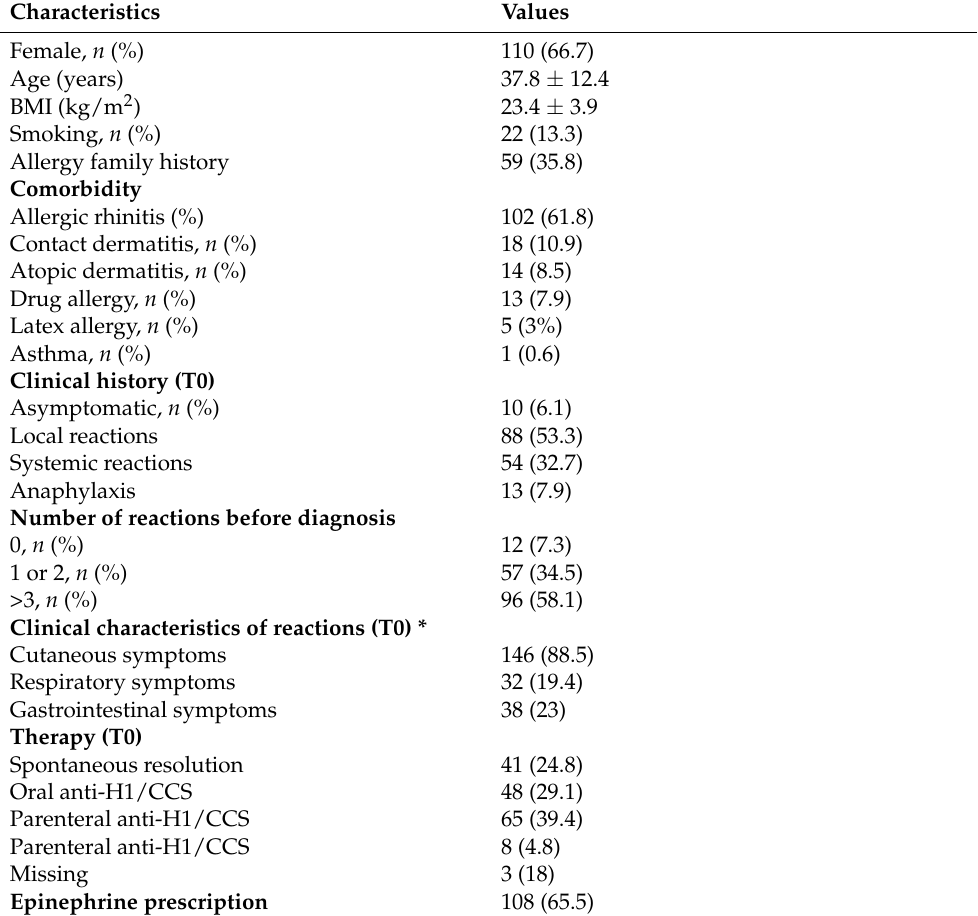
Table 1. Demographic and clinical characteristics of patients